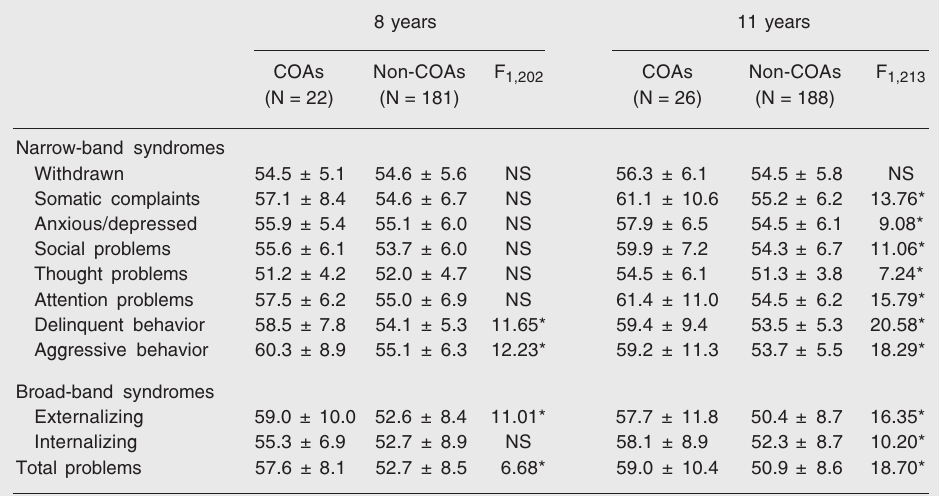
Table 4. Child Behavior Checklist ratings at 8 and 11 years (total